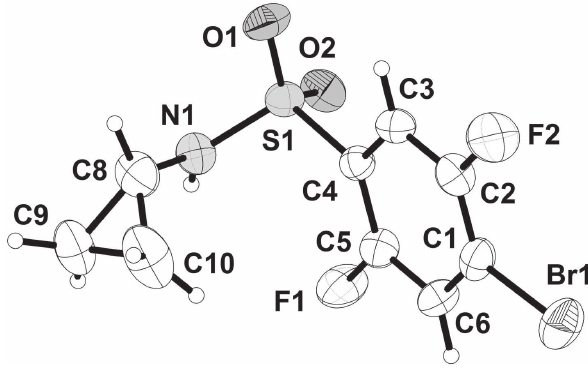
Table 2: Fractional atomic coordinates and isotropic or equivalent isotropic displacement parameters (Å 2